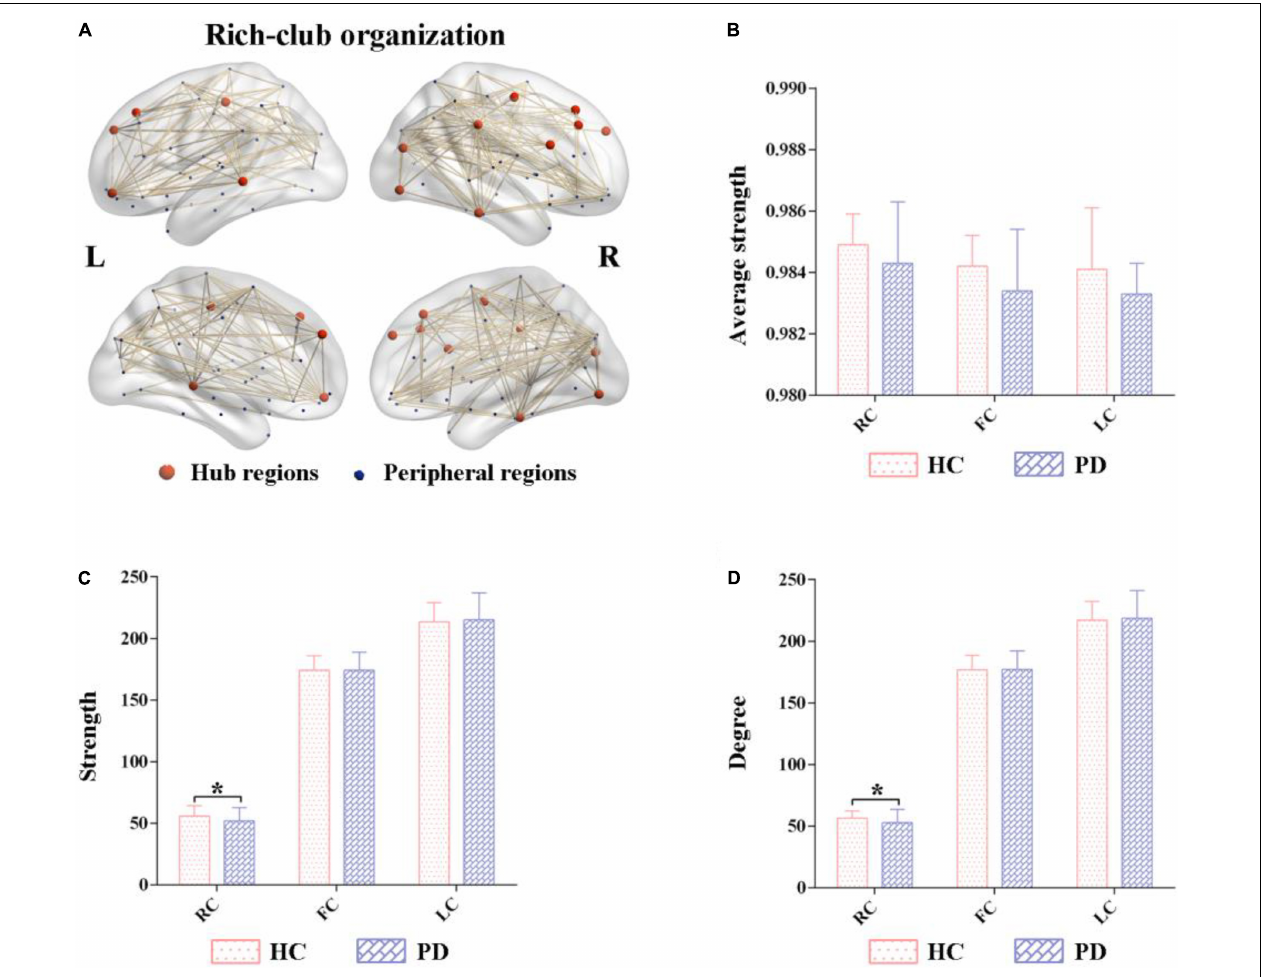
FIGURE 2 | Altered rich-club organizations of metabolic networks in Parkinson’s disease (PD) and healthy control (HC). (A) The top 14 (15%) highest-degree nodes (hub regions) and the remaining 76 regions (peripheral regions). (B–D) Comparisons of the strength and degree of rich-club connections were significantly different between PD and HC. In contrast, their feeder and local connections were comparatively similar. PD, Parkinson’s disease; HC, healthy control.